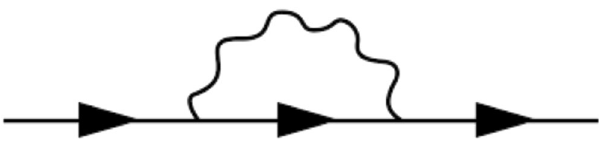
Fig. 4 Electron self-energy. Feynman diagram of the electron self-energy at the lowest perturbative order. The solid lines represent the electron propagator, while the wavy line represents the charge density fl uctuation (CDF) propagator,